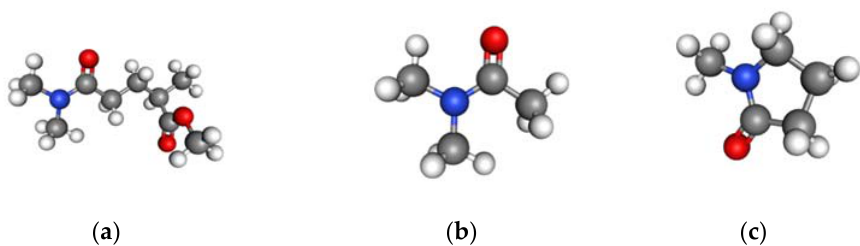
Figure 5. Chemical structure of three solvents: ( a ) PolarClean; ( b ) DMAc; ( c ) NMP. (Blue: Nitrogen, Red: Oxygen, Grey: Carbon, White: Hydrogen).